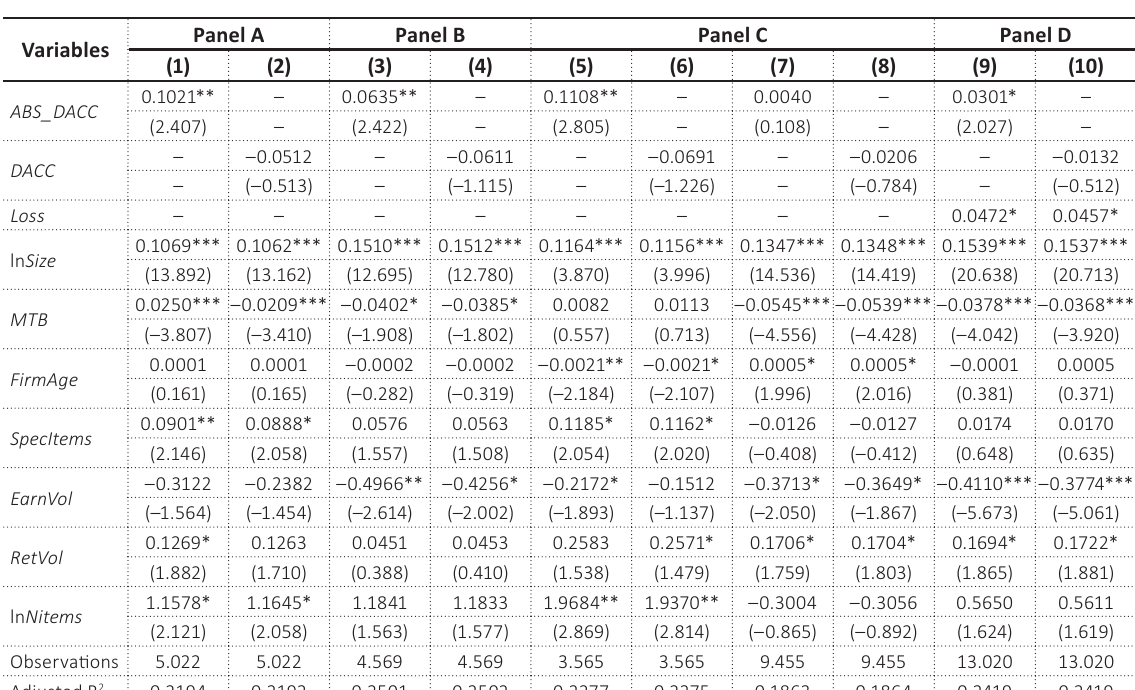
Table 3. Influence of predominant countries and industries, company size and reporting